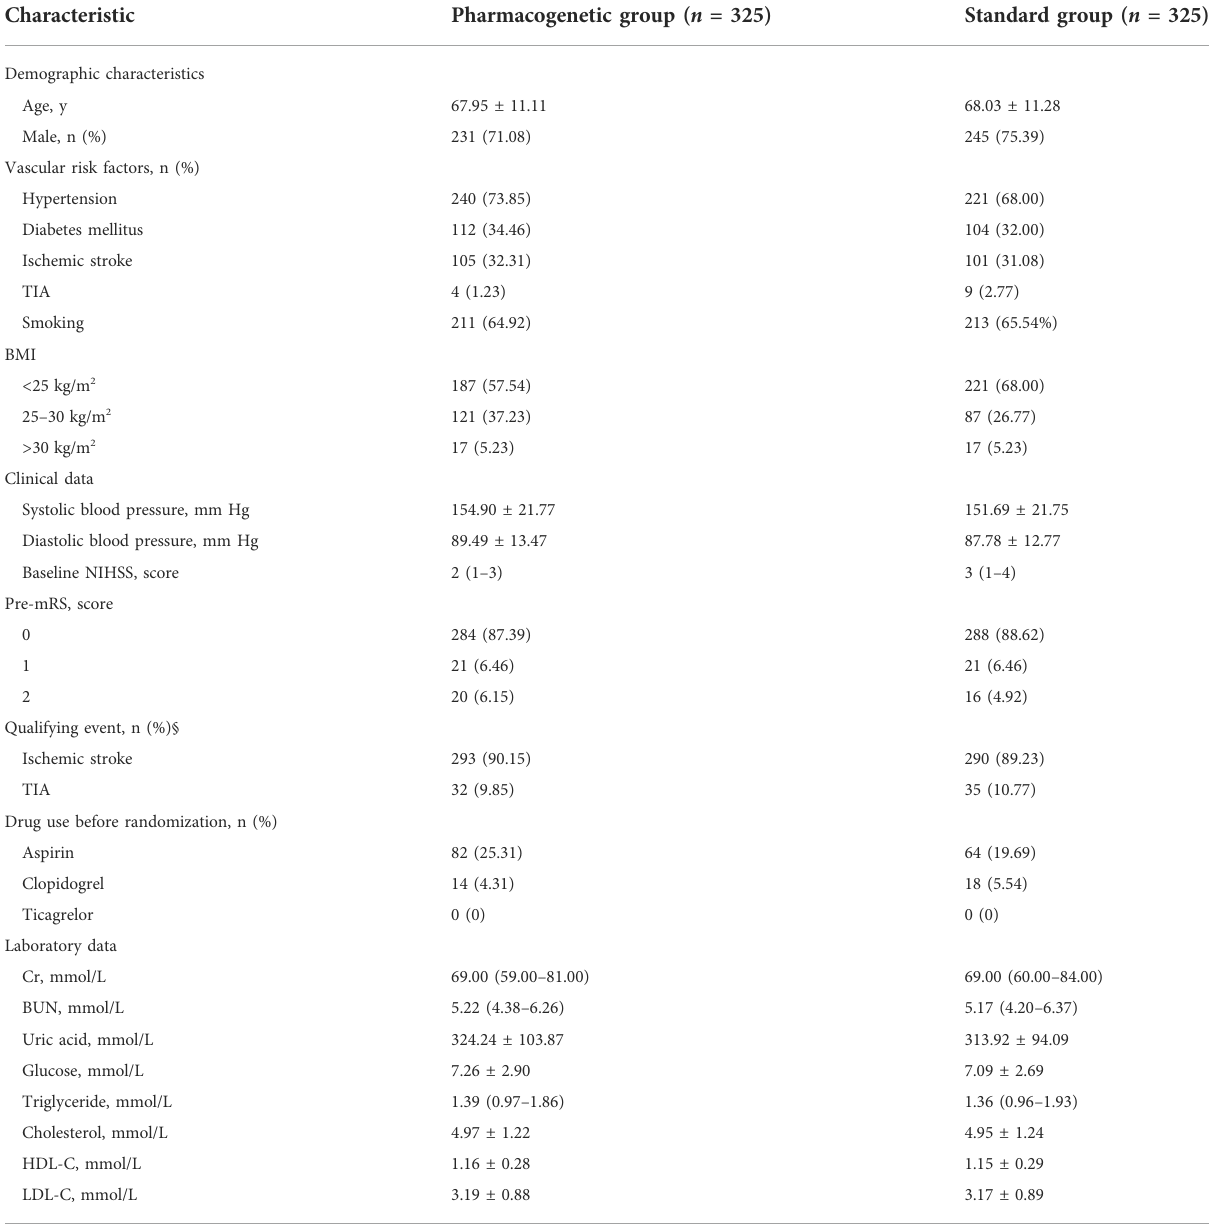
TABLE 1 Baseline characteristics of patients in the pharmacogenetic or standard